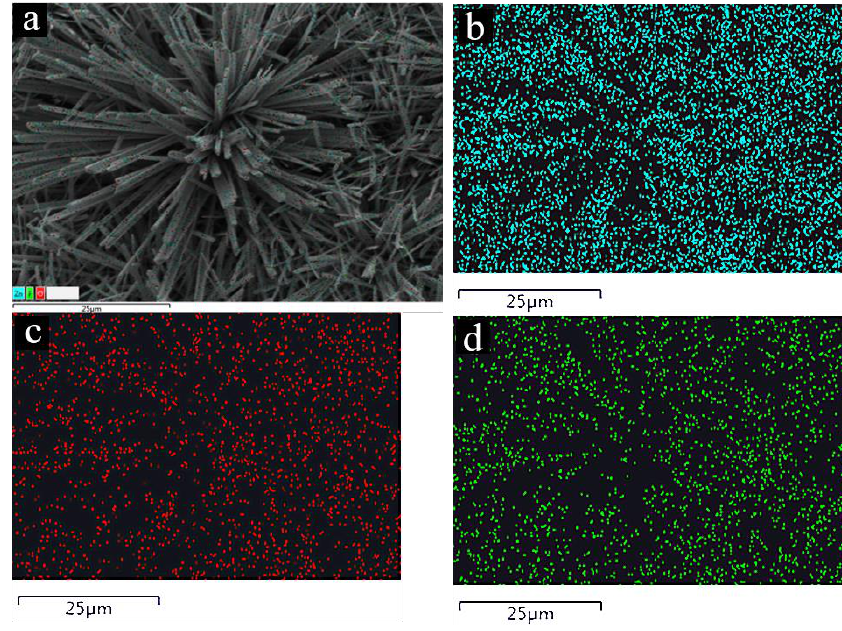
Figure 3. SEM-EDX elemental mapping images: ( a ) the elemental distribution image of zinc foil with Zn(OH)F grown on its surface; the elemental distribution data of ( b ) Zn, ( c ) O, and ( d ) F elements.